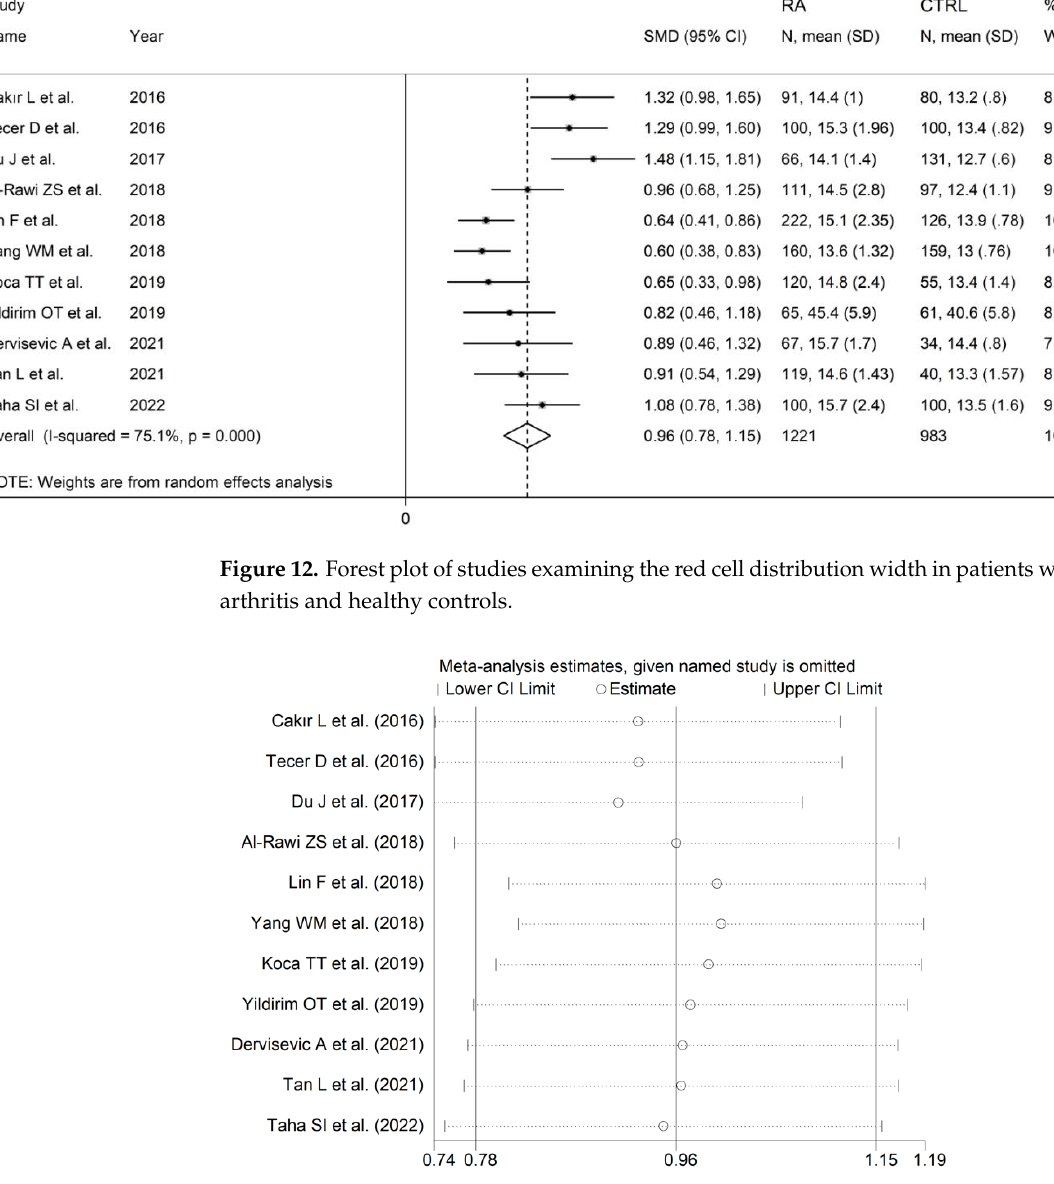
effect size computed from a meta-analysis excluding that study. size computed from a meta-analysis excluding that